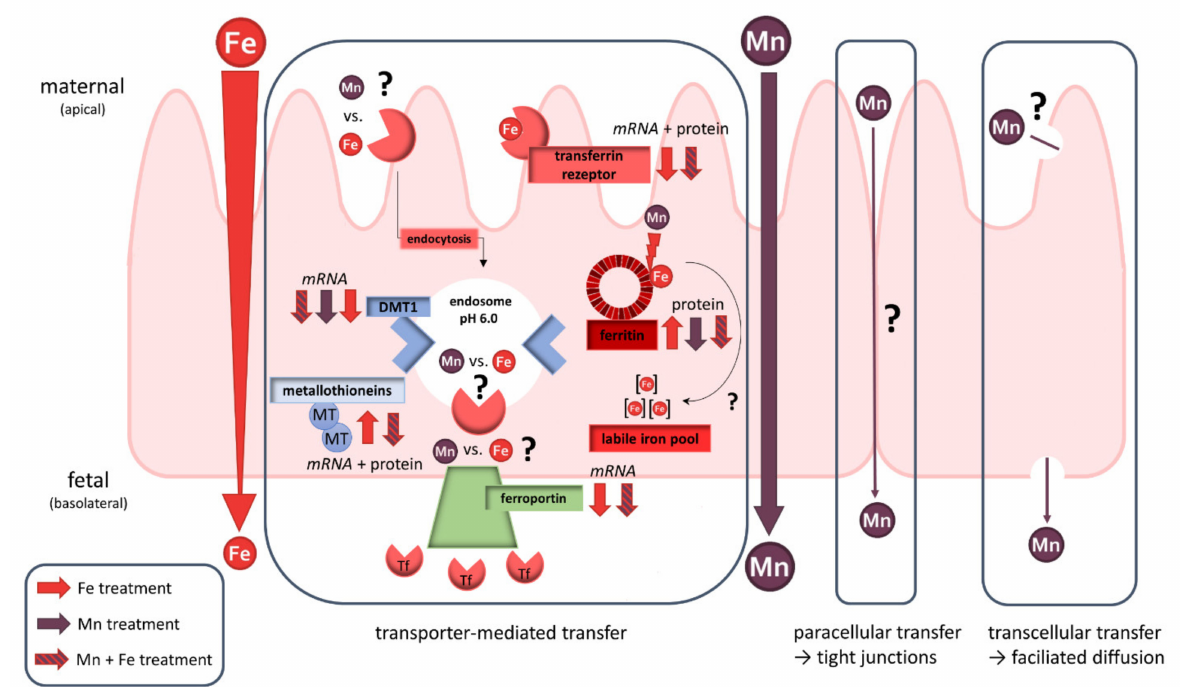
Figure 6. Schematic overview of placental transfer processes of Mn and/or Fe and their effect on transporter expression in the BeWo b30 trophoblast. While Fe seems to be transferred transporter- mediated, Mn transfer appears to follow several transfer mechanisms like paracellular, transcellular, and transporter-mediated